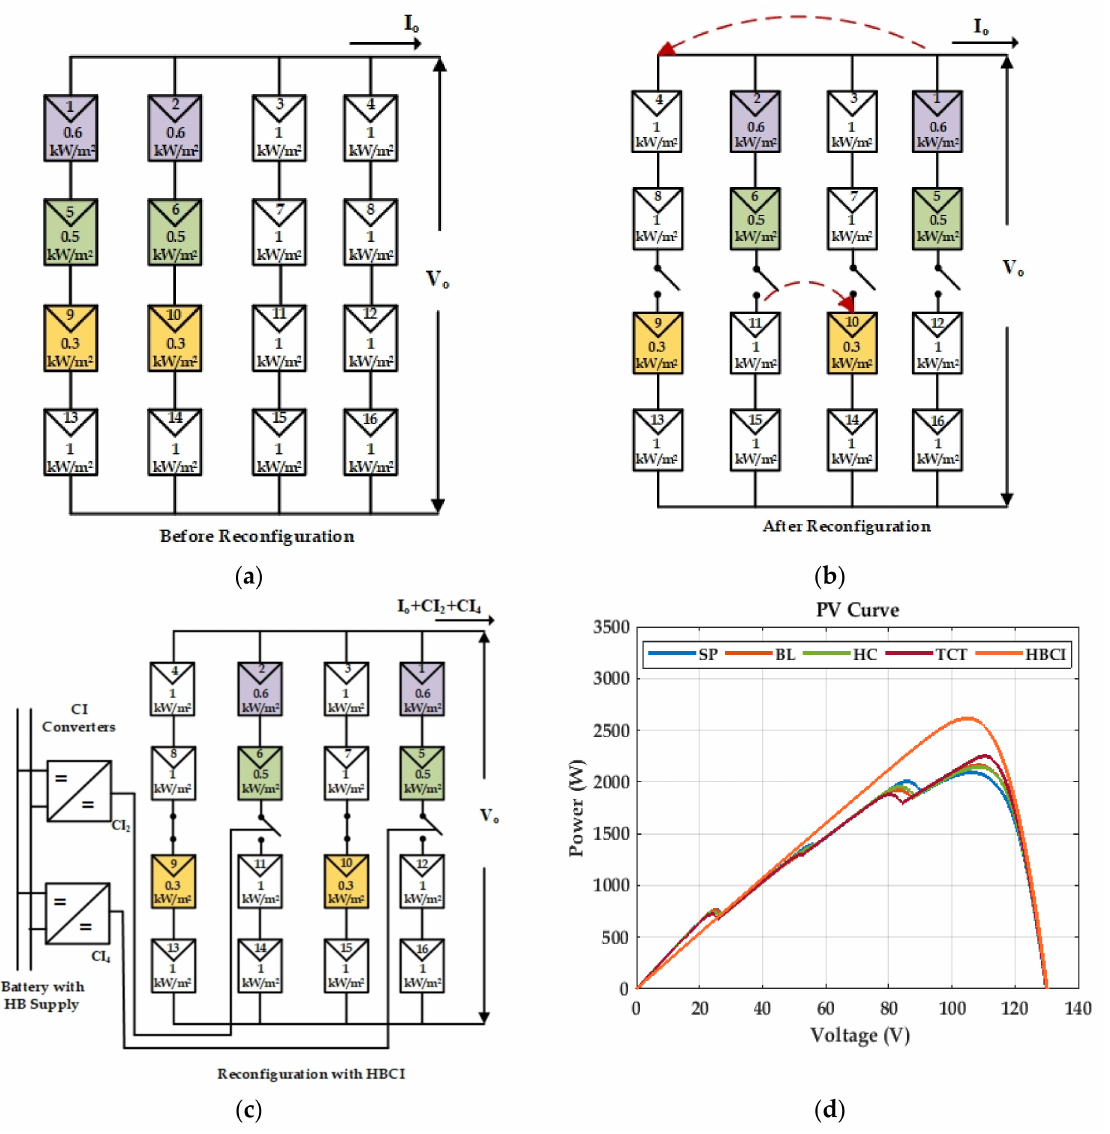
Figure 10. Case 2: corner shading: ( a ) the SP array configuration; ( b ) after reconfiguration with HBCI; ( c ) reconfiguration with HBCI; ( d ) PV